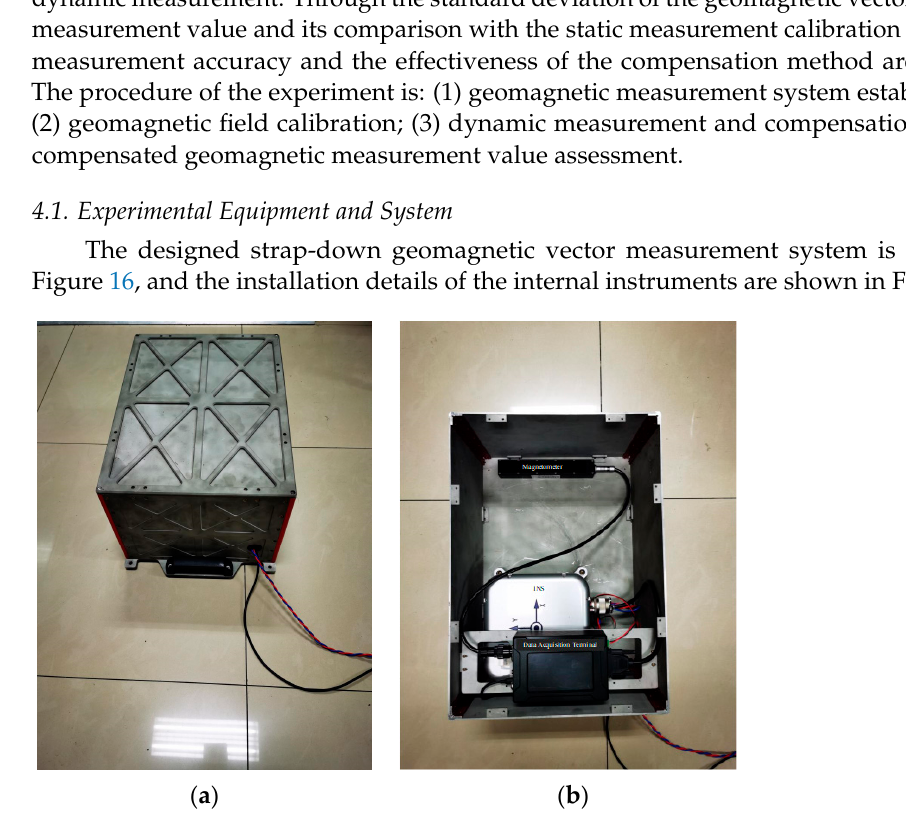
( b ) internal system composition.